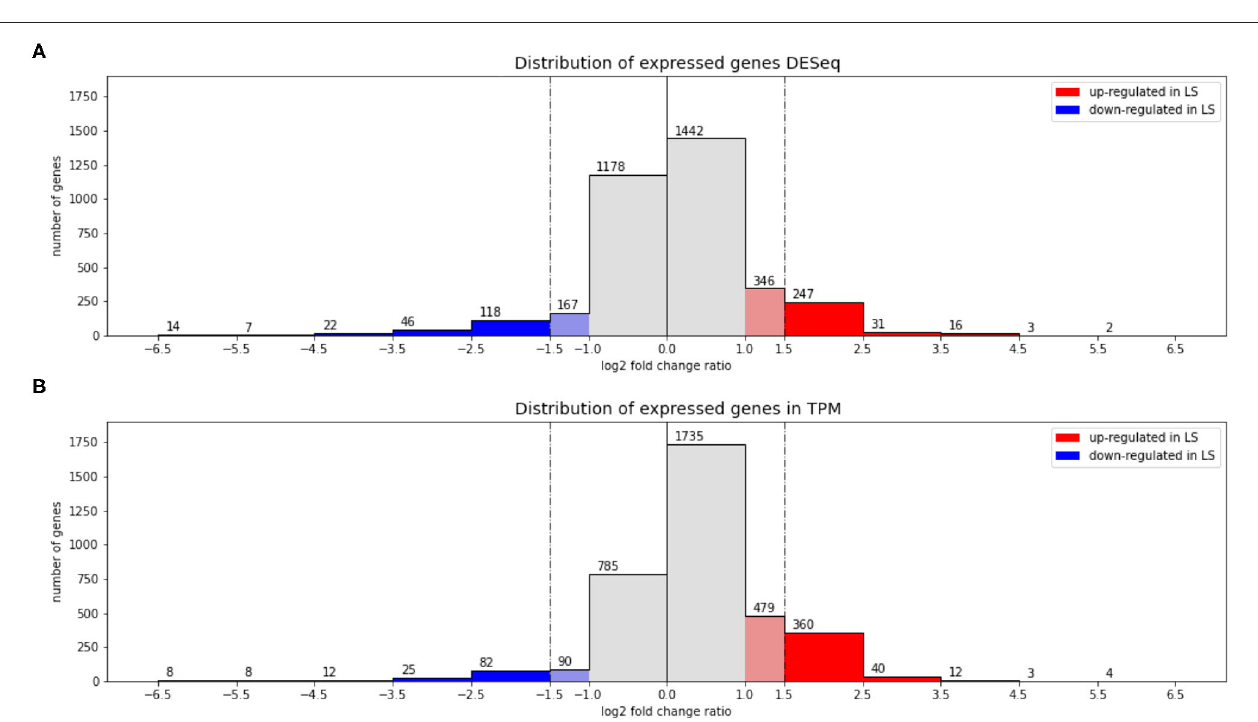
FIGURE 2 | Asymmetry in low vs. high salt regulation. (A) Shows a histogram of log2-fold-changes obtained using DESeq and (B) the equivalent for TPM. Vertical lines show the chosen threshold to consider a gene differentially expressed (see text for details).